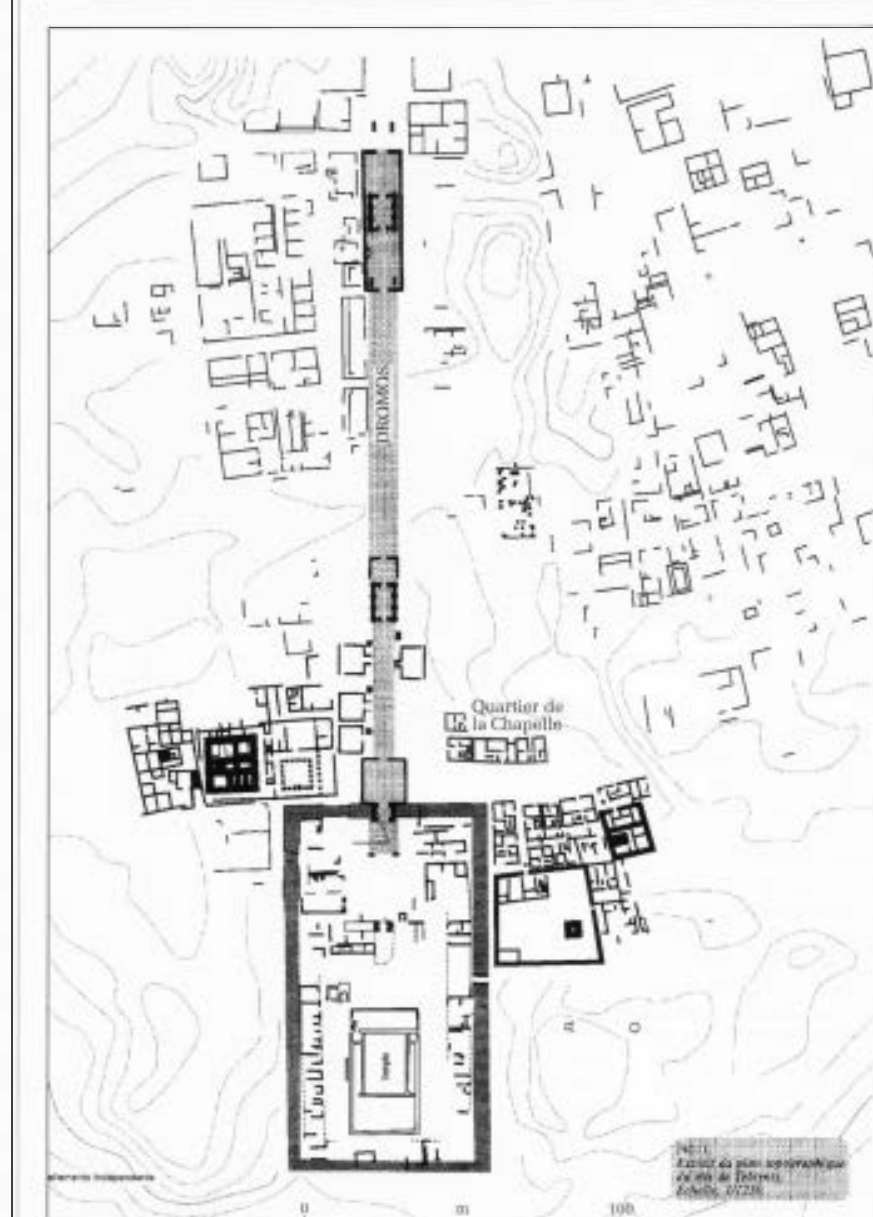
Figure 3 Ancient Tebtunis, showing the area of the temple of Soknebtunis, its proces­ sional way or dramas, and the location of the sanctuary of Isis, within the Quartier de la Chapelle (based on fig. 1 in Galazzi & Hadji-Mina, 2000, seen. 6